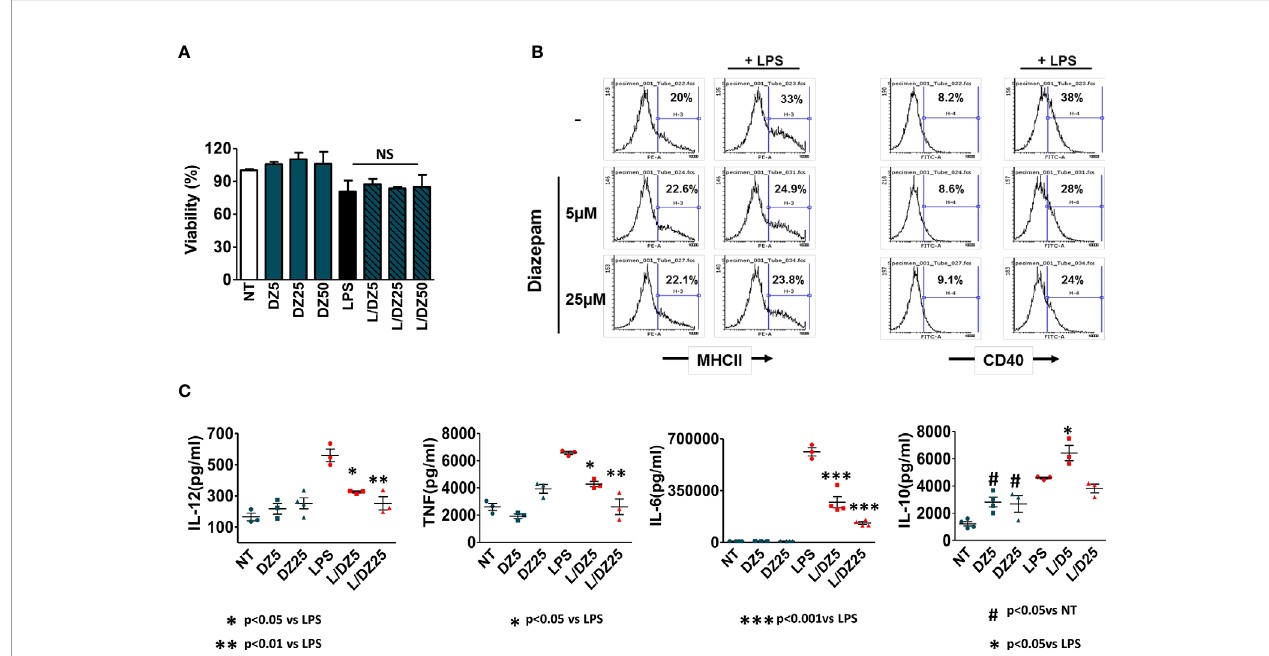
FIGURE 3 | Diazepam (DZ) has an inhibitory effect on LPS-induced dendritic cell (DC) activation. Cells were isolated from bone marrow of C57BL/6 mice and differentiated into DCs. Immature DCs (1.5 × 10 6 cells/ml in 200 µl fi nal volume) were incubated in the presence of LPS (1 µg/ml), DZ (5 and 25 m M) and evaluated after 18 h of culture. (A) Cell viability was evaluated with diazepam concentrations up to 50 m M. However concentrations of 5 and 25 m M were chosen as low and high respectively. (B) MHCII positive cells and costimulatory CD40 expression were determined using speci fi c antibodies and analyzed by fl ow cytometry, (C) Cytokine production (IL-12, TNF- a , IL-6, IL-10) was evaluated by ELISA in supernatants. Data are representative of three independent experiments. Signi fi cant differences vs. LPS-treated cells are indicated by * p < 0.05, ** p < 0.01, *** p < 0.001 and vs. nontreated cells by # p < 0.05. Non-signi fi cant values are expressed as